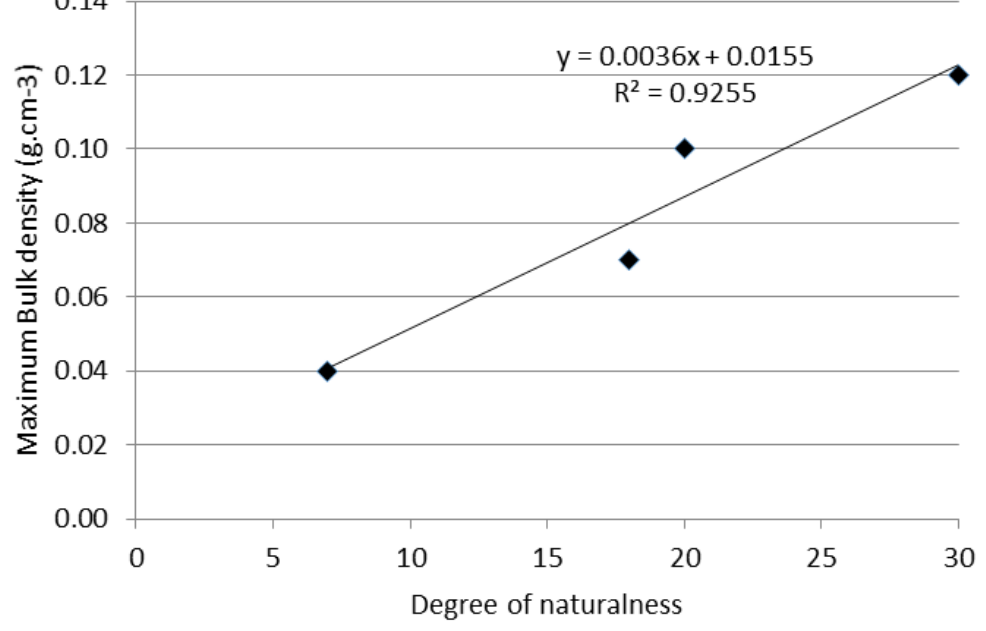
Figure 6. Degree of naturalness (DN) versus maximum bulk density (BD) of the studied